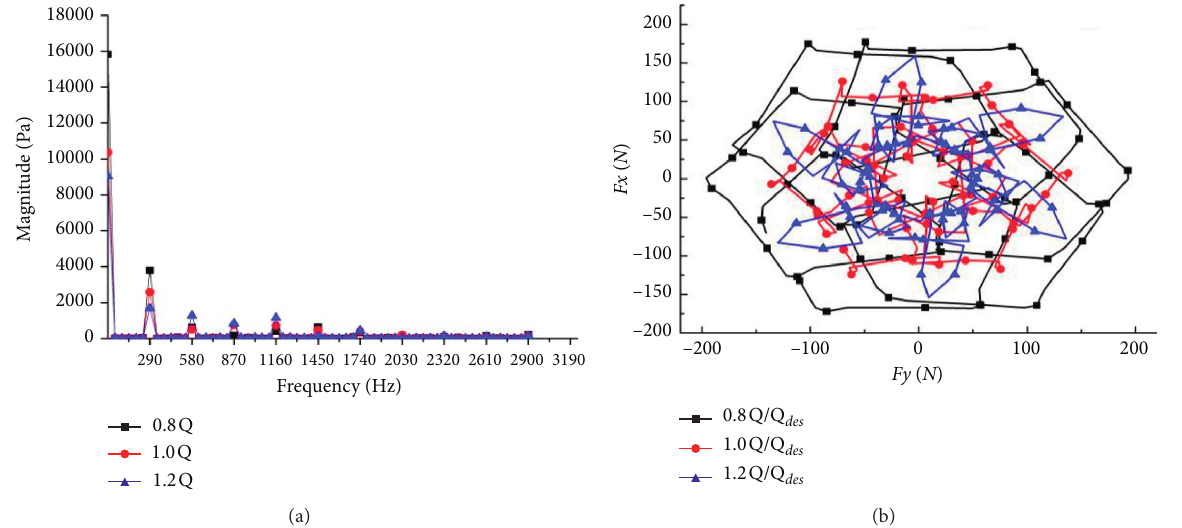
Figure 6: Frequency domain and vector distribution of radial force acting on the impeller at different flow rates. (a) Fourier transform frequency domain. (b) Radial force